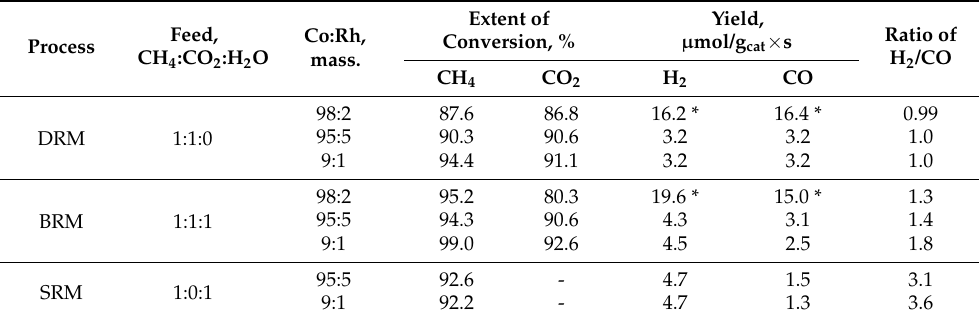
Table 3. Comparison of the performance of 5%Co-Rh/Al 2 O catalysts in methane reforming processes at t = 700 ◦ C, P = 1 atm, GHSV = 1000 h − 1